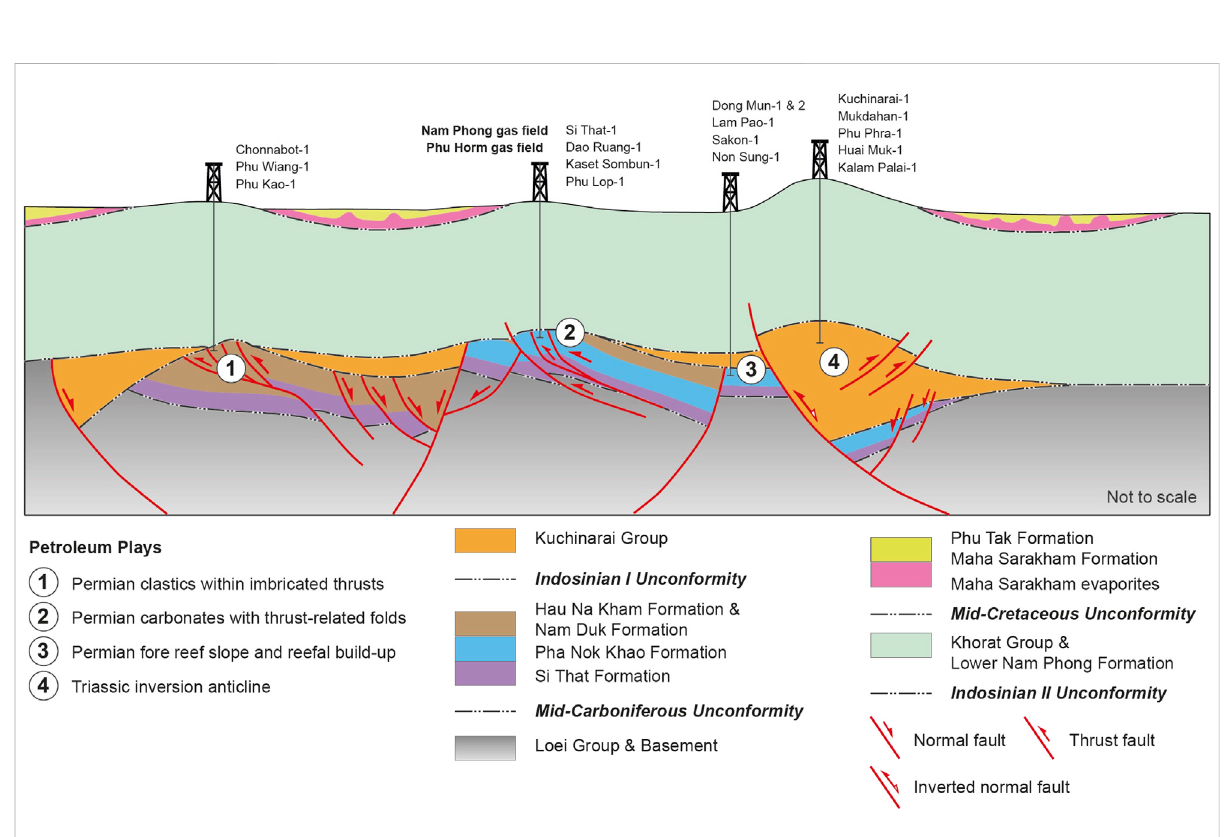
FIGURE 7 A schematic cross-section illustrating petroleum play concepts in the Khorat Plateau (modi fi ed from Booth, 1998; Booth and Sattayarak,